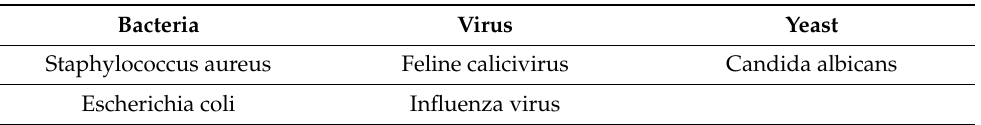
Table 2. Types of pathogens used in the study.